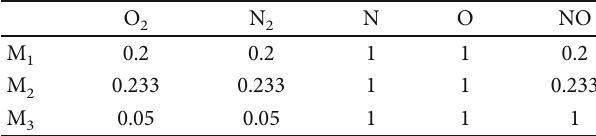
Table 2: Catalytic e ffi ciency of the third